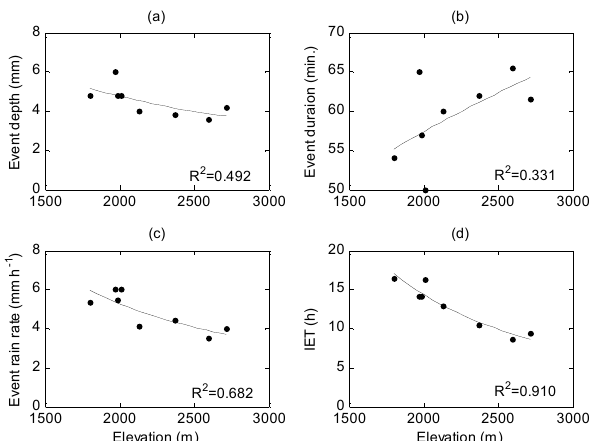
Fig. 6 Relation between event properties and terrain elevation. The event properties 759 Fig. 6. Relation between event properties and terrain elevation. The are (a) Event depth, (b) Event duration, (c) Event intensity and (d) Inter-event time 760 event properties are (a) event depth, (b) event duration, (c) event in- (IET). The median of each of the event properties is selected for the regression and 761 the regression equations are shown in Table 4. 762 tensity and (d) inter-event time (IET). The median of each of the 763 event properties is selected for the regression and the regression equations are shown in Table 4.